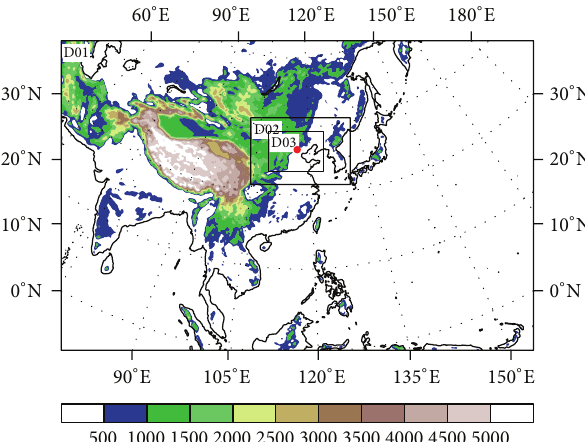
Figure 3: The model domain. The outer box is d01 (30 km), the inner boxes are d02 (10km) and d03 (3.3km), red dot indicate Beijing.